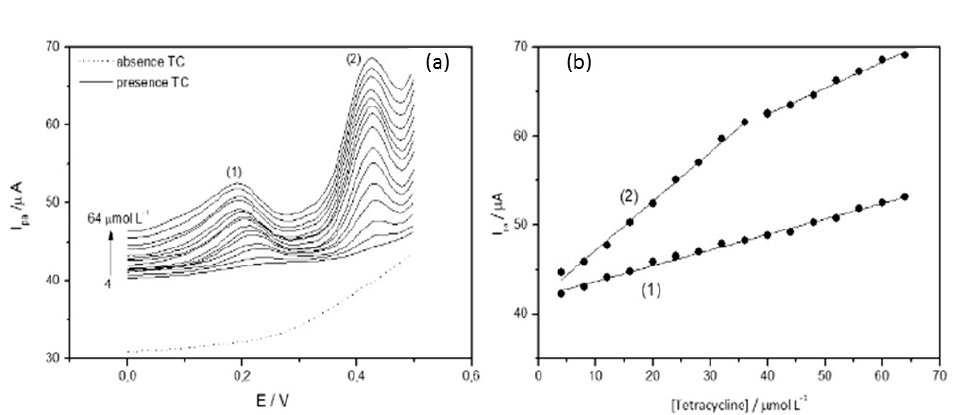
Figure 9. ( a ) Voltammograms for the detection of TC concentrations obtained for 4.0 to 64 µmol L − 1 . ( b ) Analytical curve constructed from voltammograms (Figure 9a). Measurements obtained in 1 × 10 − 3 mol L − 1 HCl at pH 3.0.